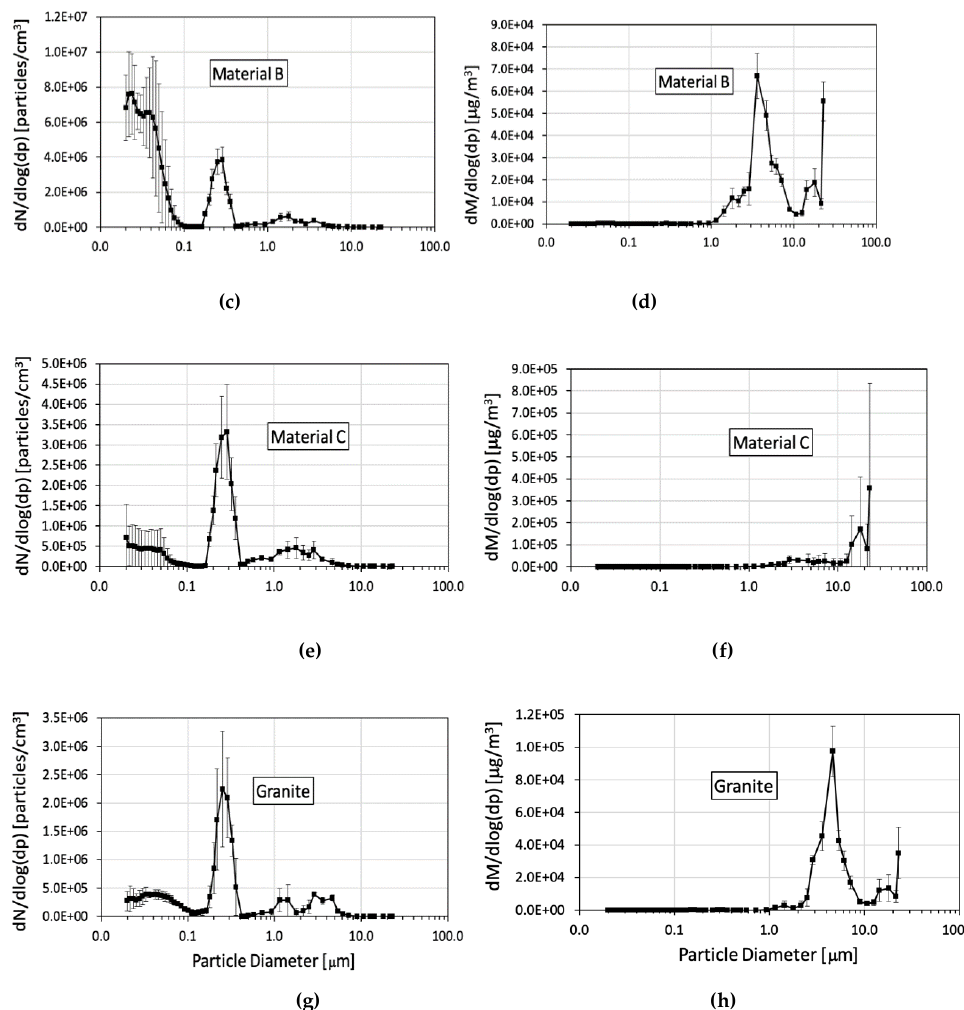
Figure 3. Average particle size distributions for all materials. Particle distributions by number are presented in the left column panels ( a,c,e,g ), Material A and Material B had a main peak in the nanometer range, between 0.01 and 0.1 µ m, and a secondary peak between 0.15 and 0.4 µ m ( a,c ). The main number concentration peak for Material C and for Granite was located between 0.15 and 0.4 µ m, and the secondary peak was between 0.01 and 0.1 µ m ( e,g ). Particle distributions by mass are presented in the right column panels ( b,d,f,h ) and were between 3 and 10 µ m and above 20 µ m for Material A ( b ). For Material B, the main peak was located between 1.0 and 10 µ m ( d ). The main mass peak of Material C was above 10 µ m ( f ) while for granite it was between 0.2 and 10 µ m ( h ). Error bars represent standard deviation of three runs.